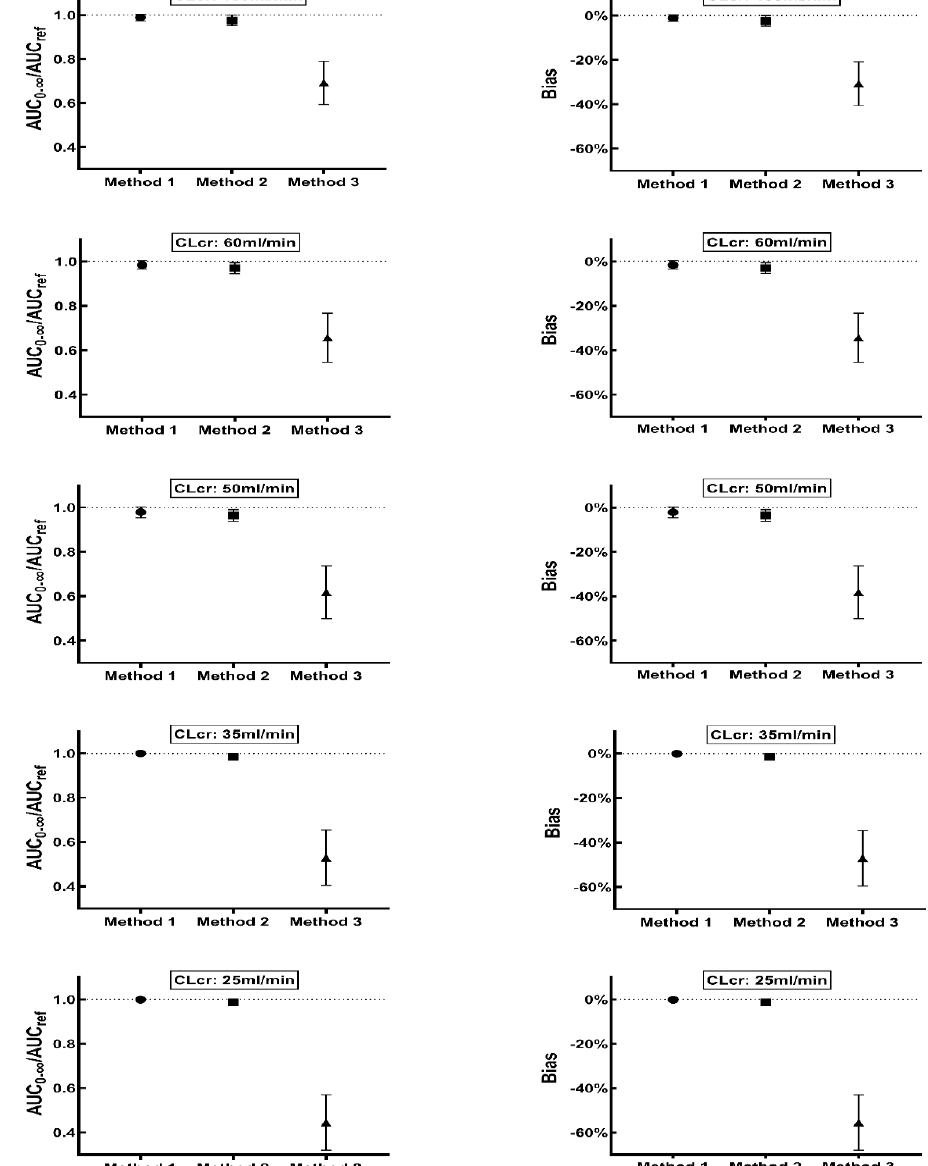
Figure 3. Ratio of AUC 0 –∞ : AUC ref ( left panel ) and Bias ( right panel ) calculated using three methods in patients with various degrees of renal function (CLcr value: 100, 60, 50, 35 and 25 mL/min). Data is presented as mean and SD. The solid circle, square, triangle represent the mean value of AUC 0 –∞ : AUC ref ( left ) or Bias ( right ) using Method 1, Method 2, and Method 3, respectively.